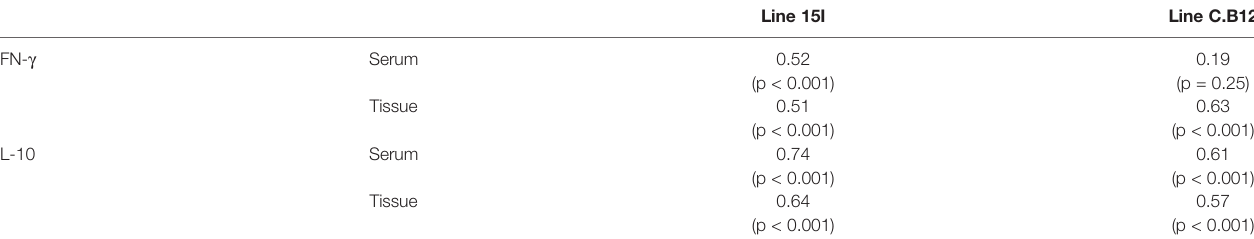
TABLE 4 | Correlation of IFN- g and IL-10 in serum and jejunum with E. maxima